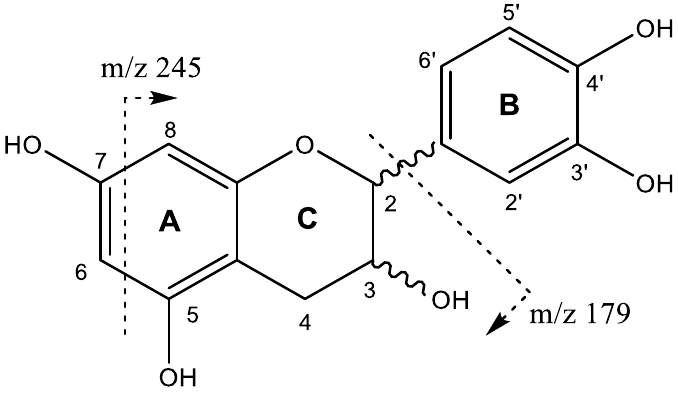
Figure 1. UPLC-QTOF-ESI MS chromatograms (from top to bottom) of: ( a ) flavan-3-ol monomers, ( b ) procyanidin (epi)catechin dimers ( c ) propelargonidin (epi)afzelechin-(epi)afzelechin dimers, ( d ) propelargonidin (epi)afzelechin-(epi)catechin dimers. The flavan-3-ols monomers catechin and epicatechin (Figure 2) were tentatively as- signed to peaks 14 (Rt = 12.83 min) and 30 (Rt = 17.24 min). Both peaks show a [M-H] − at m / z 289.0729 (C 15 H 13 O 6 ) with main fragments m / z 245 [M-H-42] - due to retro-Diels-Alder fission (RDA) of ring A, and m/z 179 by loss of ring B [26].